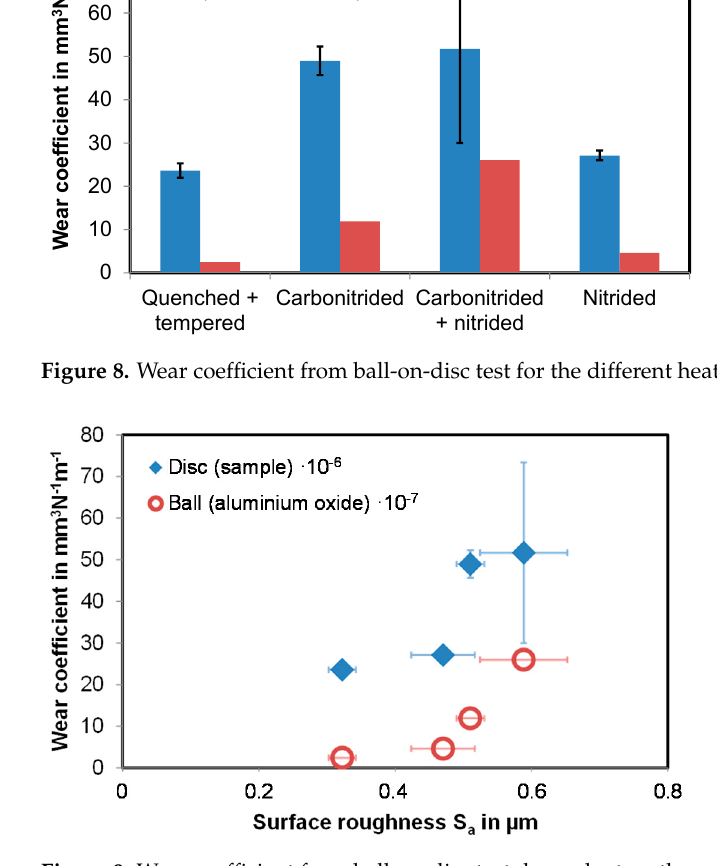
Figure 9. Wear coefficient from ball-on-disc test dependent on the surface roughness.